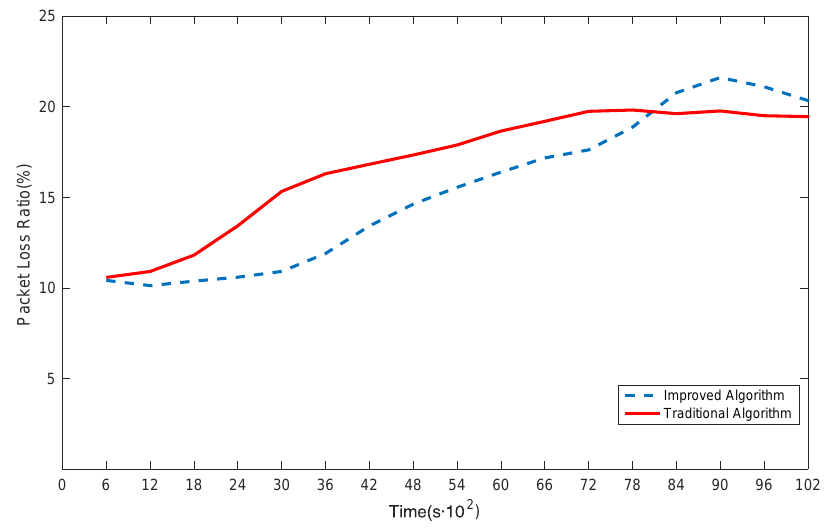
Figure 8. Comparison between the improved algorithm and the traditional algorithm.